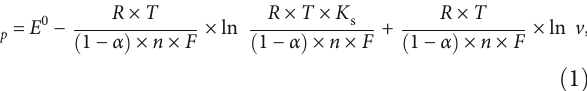
E p vs. pH, and (d) p vs.